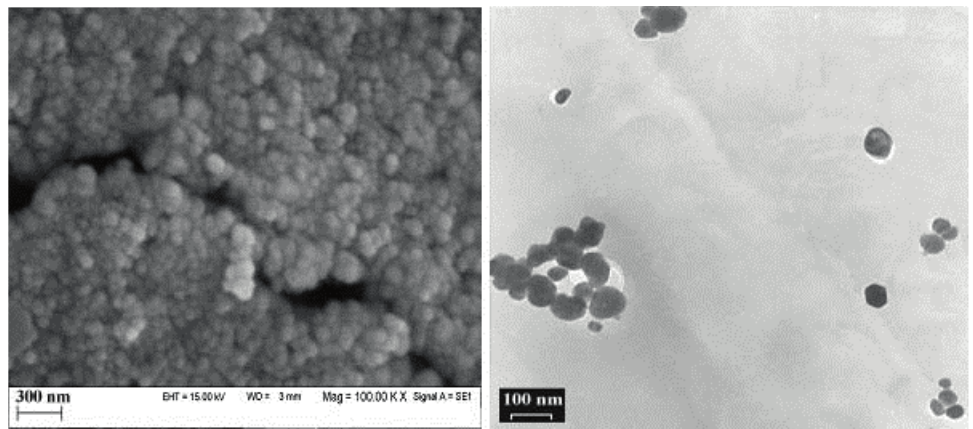
Figure 2. SEM and TEM image of CdS nanoparticles.